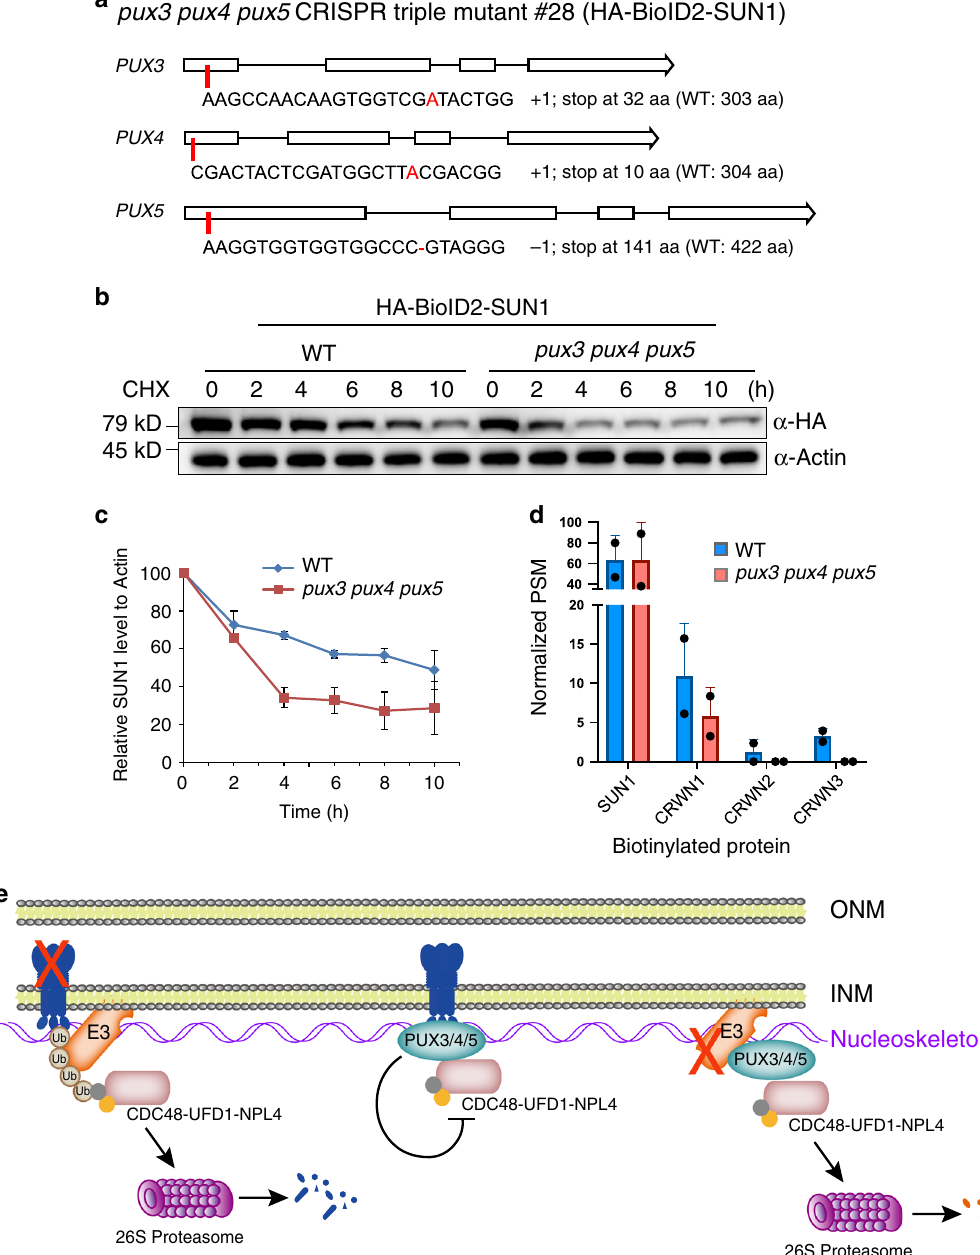
Fig. 4 PUX3, PUX4, and PUX5 negatively regulate the degradation of SUN1. a The pux3, pux4 , and pux5 mutations generated by CRISPR/Cas9 in the 35S: HA-BioID2-SUN1 background. b In vivo degradation assay for HA-BioID2-SUN1 in WT and the pux3 pux4 pux5 triple mutant background. c Time-course densitometric analysis of the HA-BioID2-SUN1 protein level in the presence of CHX using actin as the control. Error bars represent SD from two independent biological replicates. d Peptide intensity values of nucleoskeleton proteins measured by PL-FLQMS using 35S: HA-BioID2-SUN1 plants in WT and pux3 pux4 pux5 background. Error bars represent SD from two independent biological replicates. e Models for the function of PUX3/4/5 in plant INM protein degradation. INM proteins are ubiquitinated by unknown E3 ubiquitin ligases and subsequently recruit the CDC48 complex for proteasome degradation (left). PUX3/4/5 play a negative role in regulating the INM protein degradation in plants. One hypothesis is that PUX3/4/5 may protect INM proteins from non-speci fi c degradation by directly interfering with the ATPase activity of CDC48 at the INM (middle). Alternatively, PUX3/4/5 may recruit the CDC48 complex to the INM to degrade the INM-localized E3 ligases that initiate INM protein degradation in plants (right). PUX3/4/5 are anchored to the INM through interacting with the